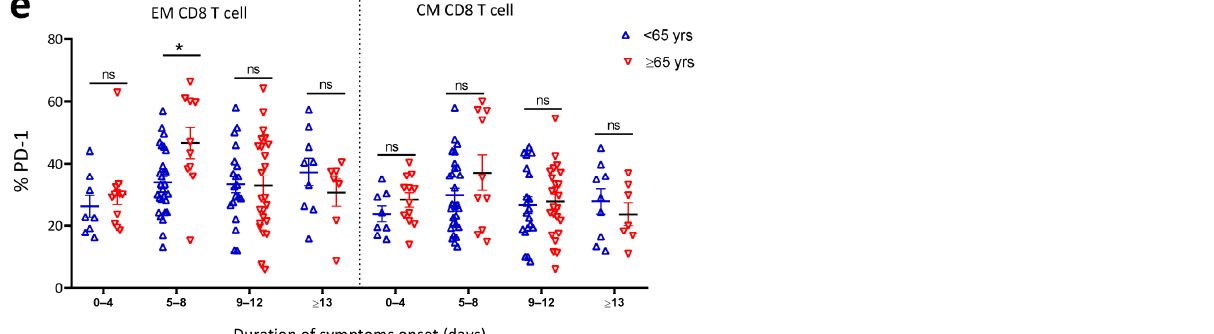
Figure 5. Reduced T cell activation in older COVID-19 patients. Cell surface staining of T cells response and cytokine level from PBMC and serum, respectively. ( a ) Percentage of CD8 T cells and ( b ) percentage of CD4 T cells from total CD3 T cells. ( c ) Percentage of CD69 expression on effector and memory CD8 T cells, ( d ) serum IFN- γ level, and ( e ) percentage of PD-1 expressing effector and memory CD8 T cells ( n = 117). The data are shown as mean ± SEM. The statistical comparison of below 65 years (<65 years) vs. above 65 years ( ≥ 65 years) was performed using Student’s t -test (ns: not significant, * p < 0.05, ** p < 0.01).